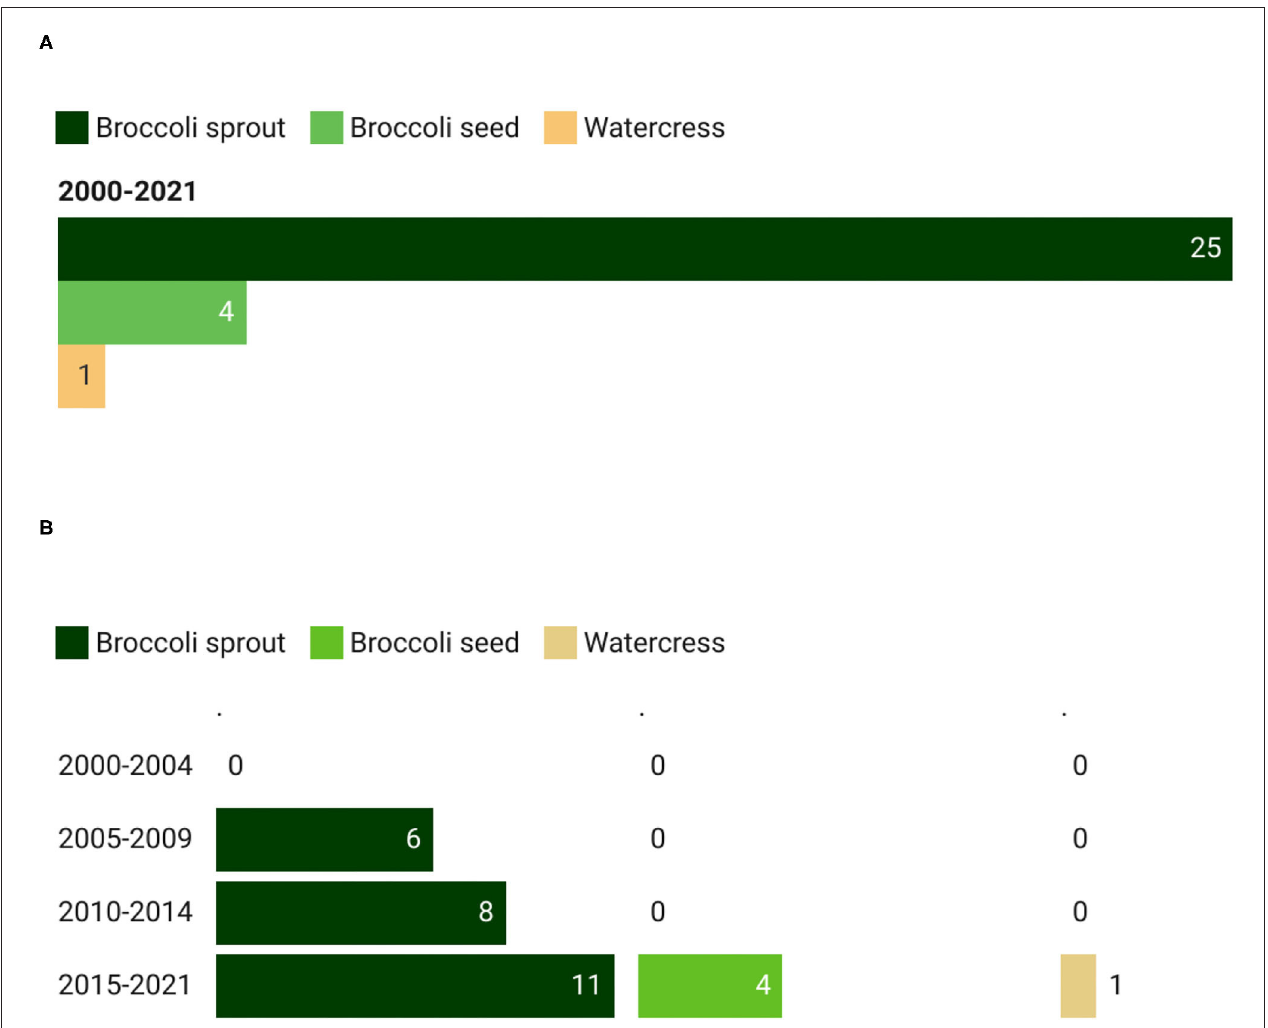
FIGURE 4 | Main GSL-rich extracts (A) used in clinical trials and their trend (B) . The total count of GSL-rich extracts is higher than the total count of the corresponding studies since in some studies more than one extract has been provided to the